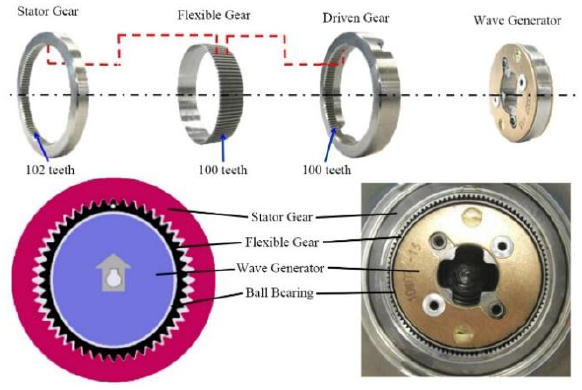
Figure 5. Structure of the reduction mechanism [17].